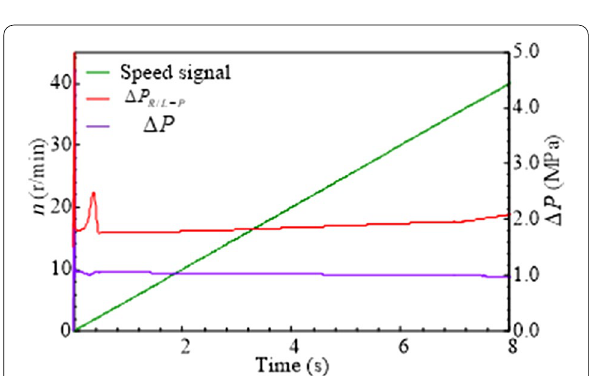
Figure 7 Relation between speed signal and (cid:31) P , � P R / L −